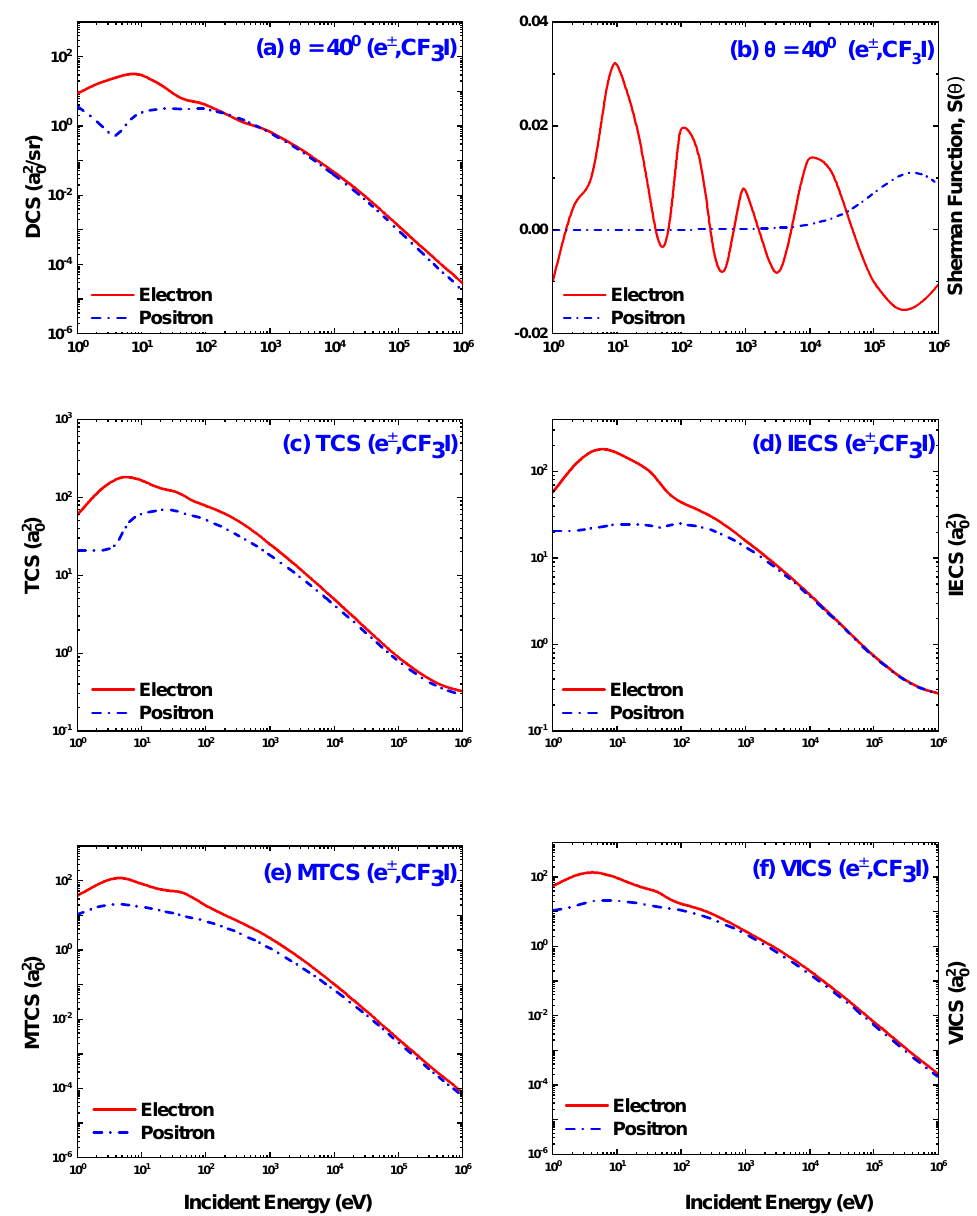
Figure 12. Comparison of the energy dependence of ( a ) DCS, ( b ) Sherman function, ( c ) TCS, ( d ) IECS, ( e ) MTCS, and ( f ) VICS between the e − -CF 3 I and e + -CF 3 I scattering. Theoretical works: Electron and